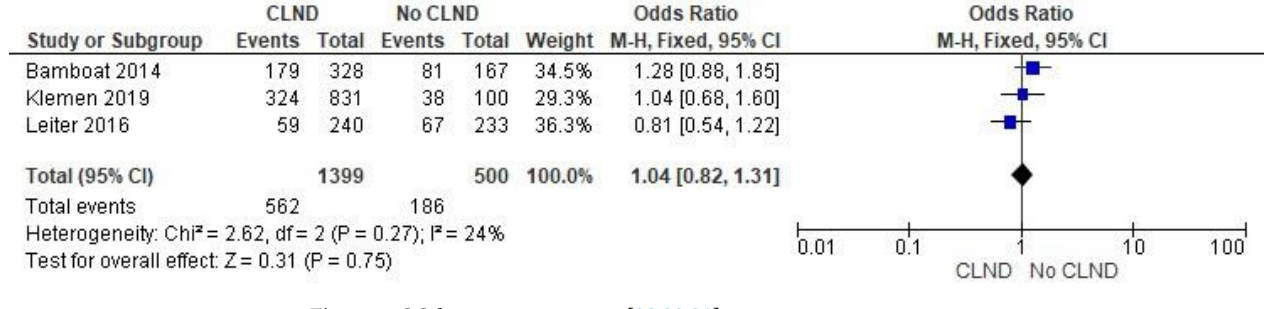
Figure 2. Melanoma recurrence [28,29,31].